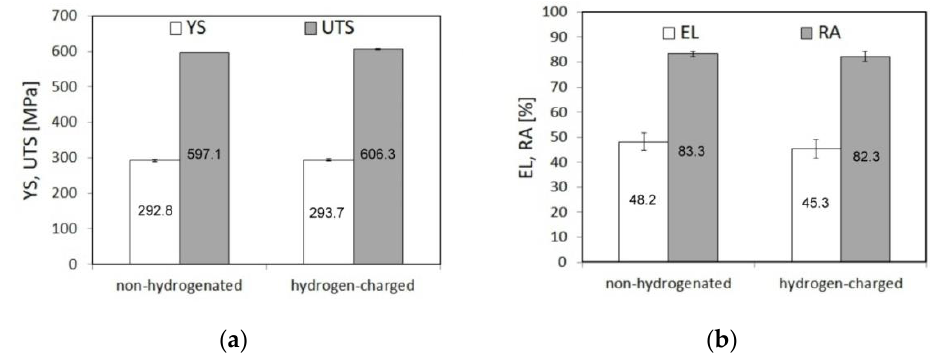
Figure 6. Room-temperature tensile properties of as-received 316H material in nonhydrogenated and hydrogen-charged material conditions: ( a ) strength properties: yield stress (YS), ultimate tensile strength (UTS); ( b ) deformation properties: total elongation (EL), reduction in area (RA).